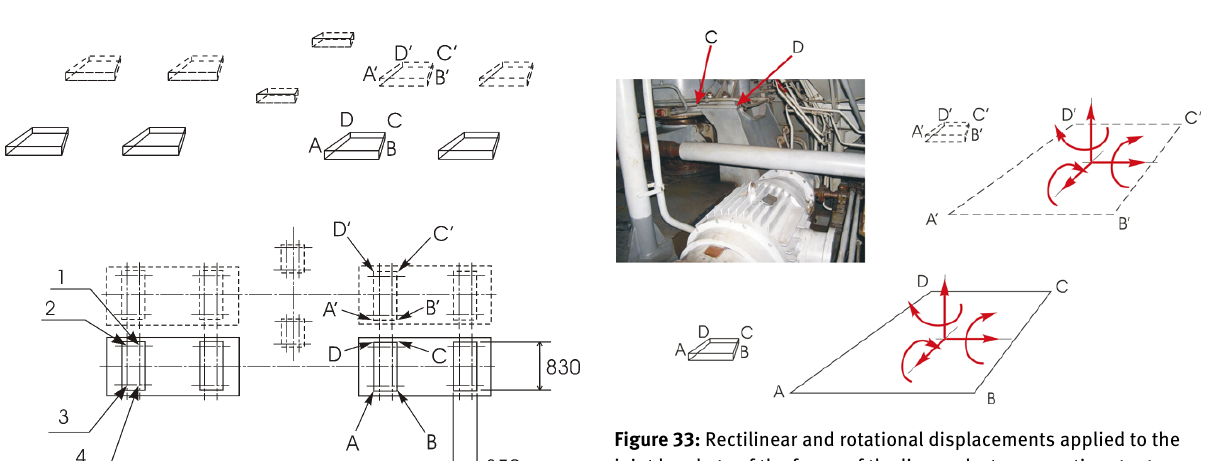
Figure 31: Dimensions of the joint plates between the oil-pressure rotary actuators and the hull.